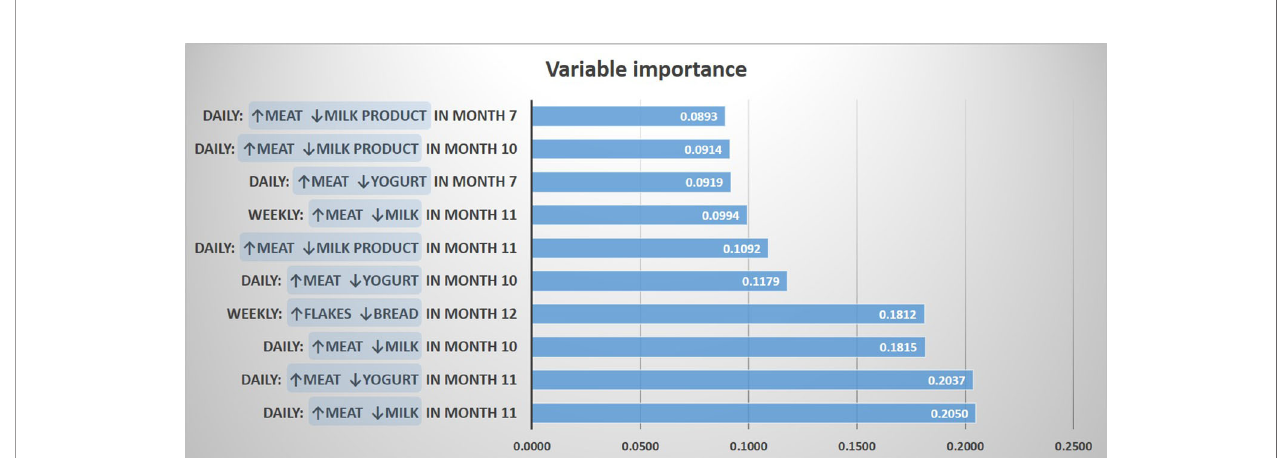
FIGURE 4 | Prediction of asthma by protein and carbohydrate sources. The 10 most important prediction variables representing contrasts between food items